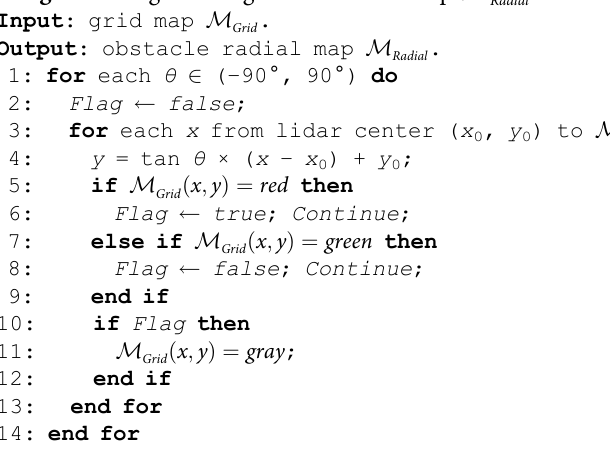
Algorithm 1 generating obstacle radial map M